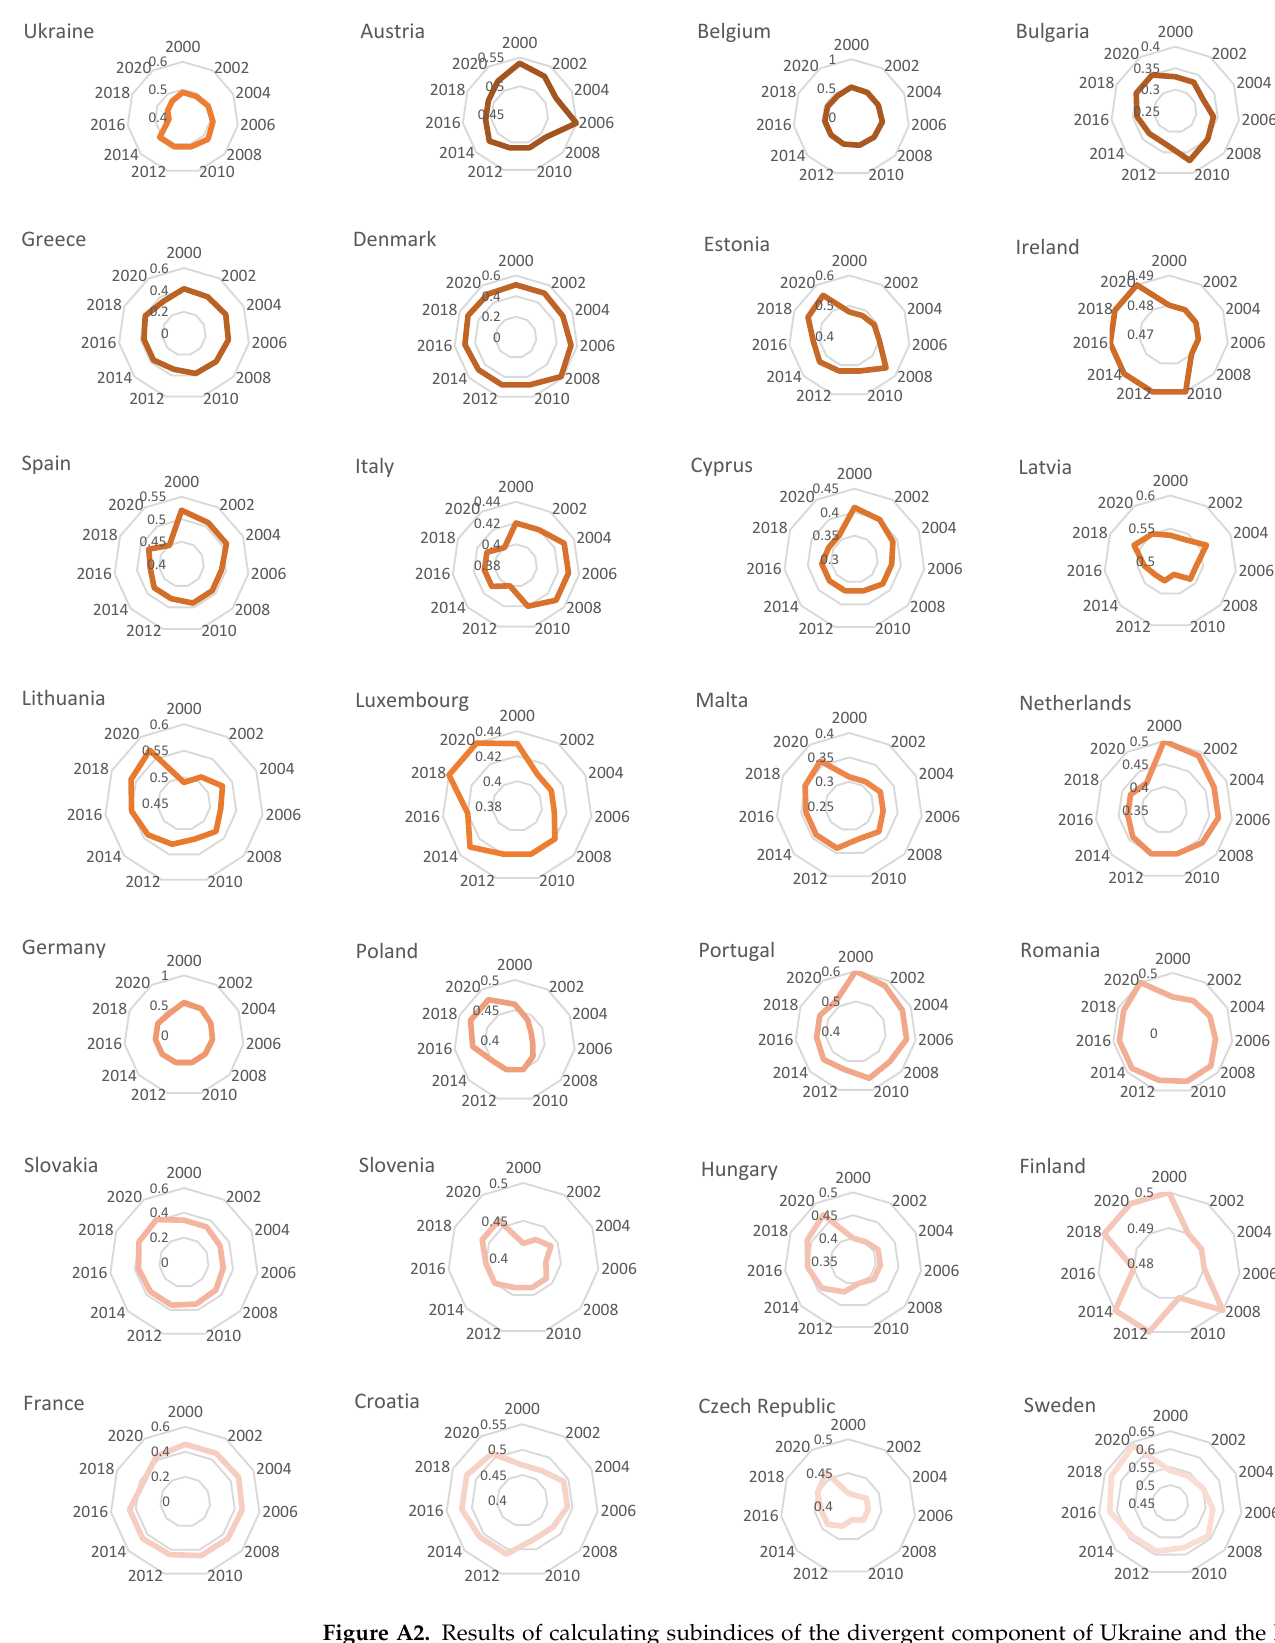
Figure A2. Results of calculating subindices of the divergent component of Ukraine and the EU countries, 2000 – 2020.